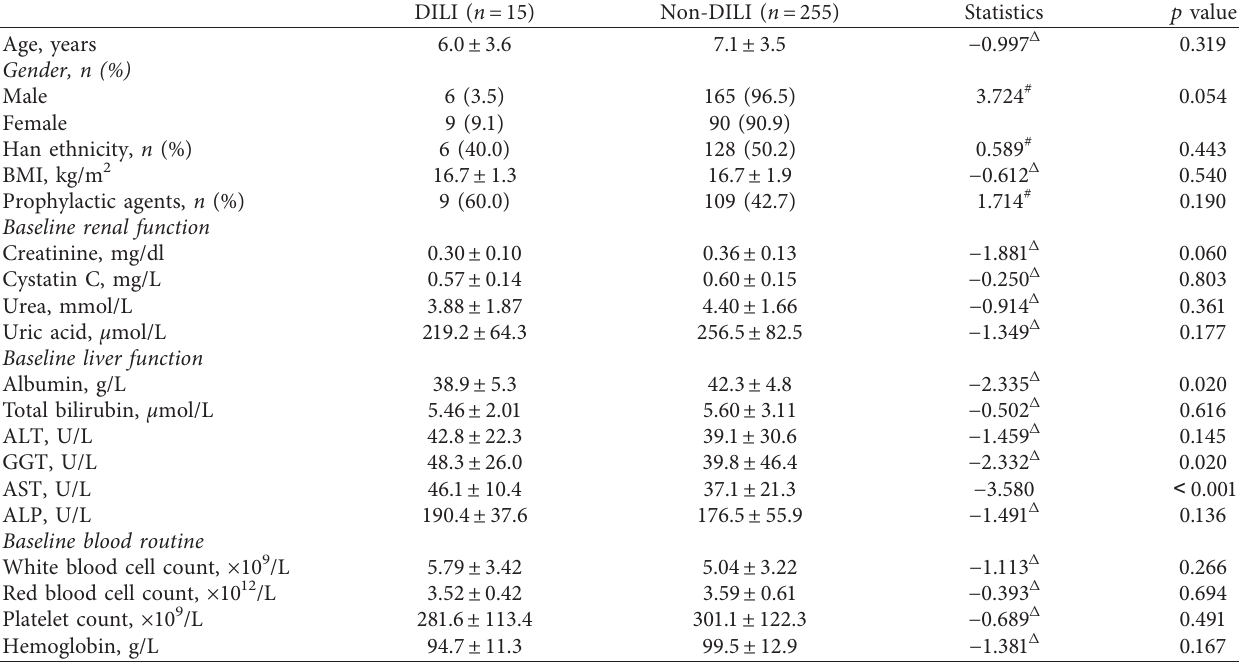
Table 5: Demographic and laboratory characteristics of DILI and non-DILI in HR cases.